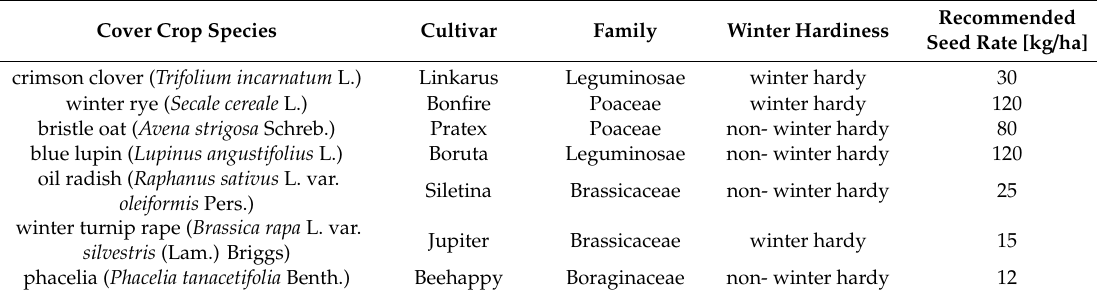
Table 3. Cover crops species of the field